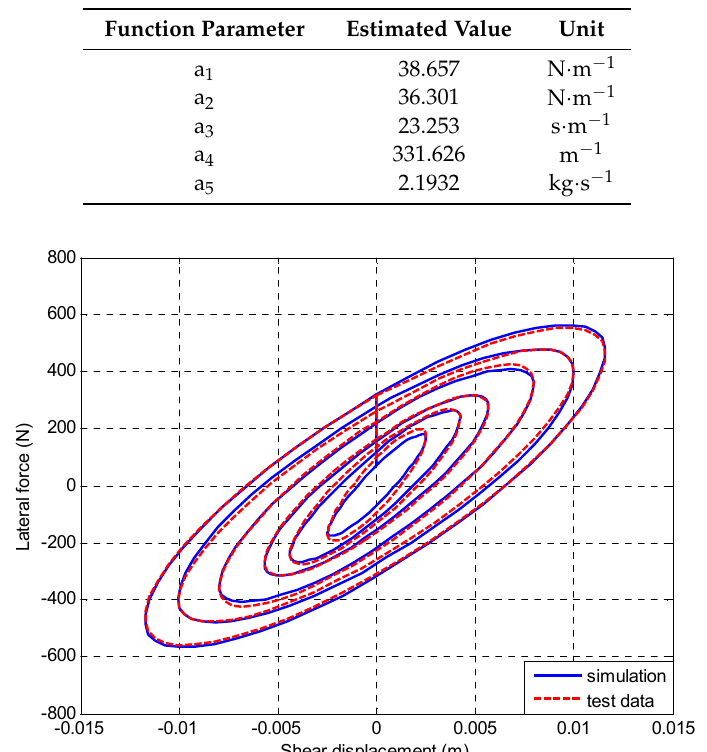
Table 2. Estimated values for function parameters for loops at excitation frequency of 2 Hz.